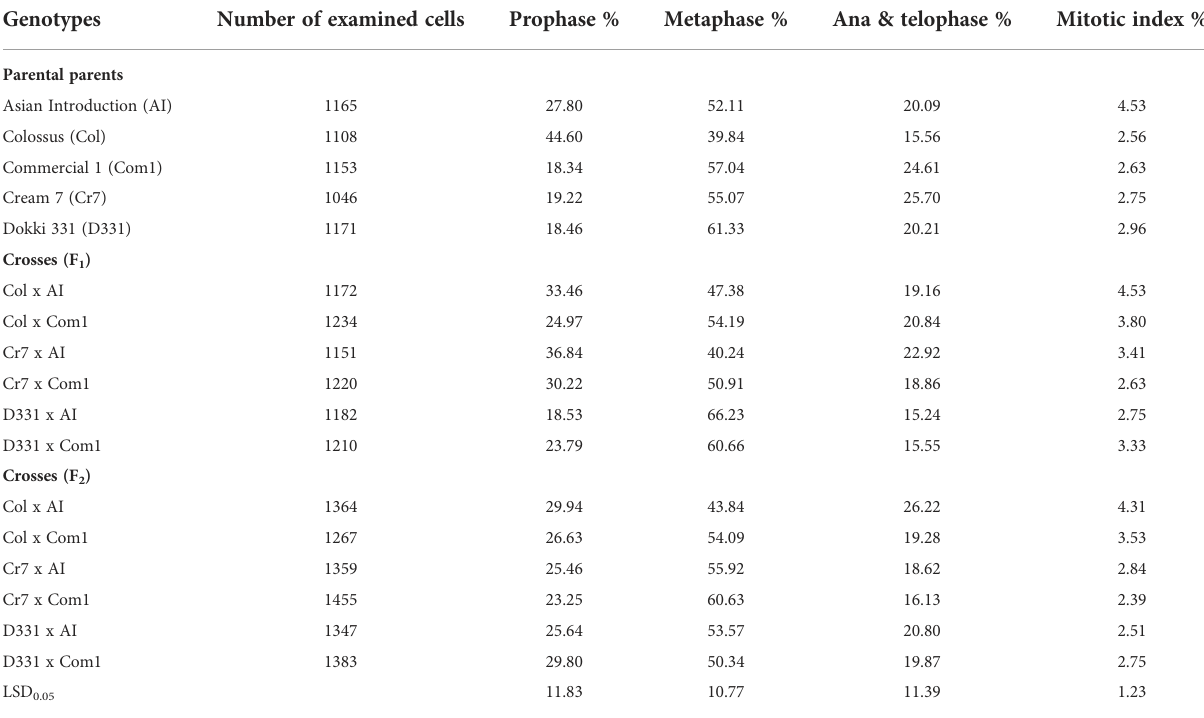
TABLE 7 Proportions of phase and mitotic index (MI) derived from the root tips of six crosses in F 1 and F 2 produced from crossing between fi ve parental genotypes; Cream 7 cv. ‘ Cr7 ’ , Colossus cv. ‘ Col ’ , and Dokki 331 cv. ‘ D331 ’ genotypes as female parents and Asian Introduction ‘ AI ’ and Commercial 1 ‘ Com1 ’ genotypes as male